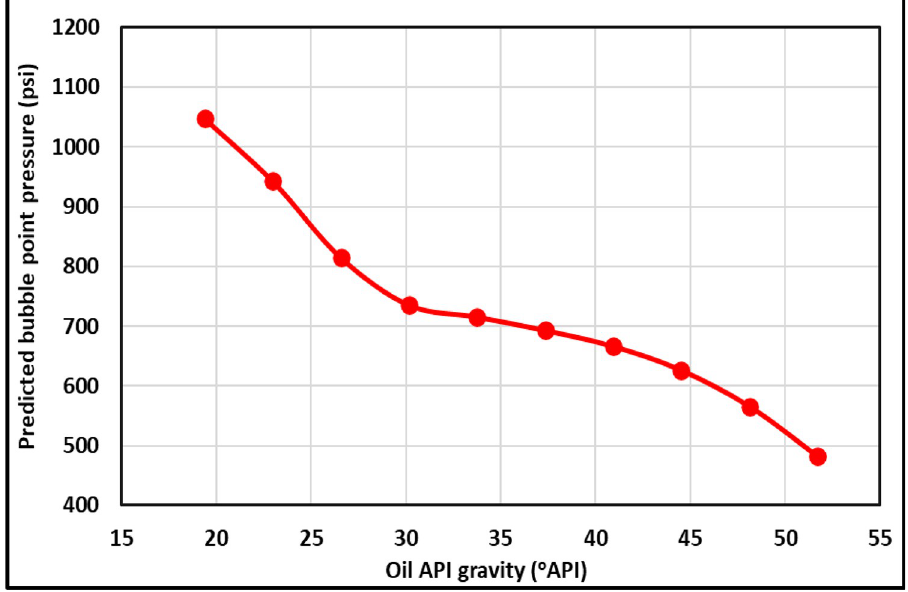
Fig 10. API TrA of the ANFIS